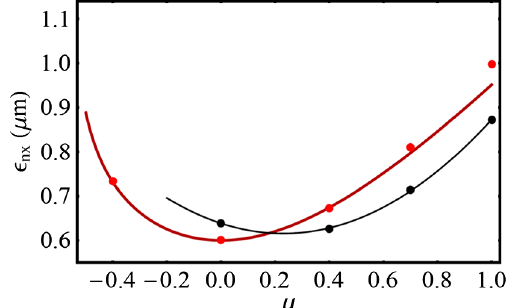
FIG. 4. Normalized projected rms emittance observed at the exit of the achromat as predicted by Eq. (32), red line, and determined by ELEGANT simulations (red dots) vs. μ , parametriz- ing the entry m 12 ¼ 15 ð 1 þ μ Þ L B = 2 of the transfer matrix M from the exit of the first to the entrance of the second bend, see Fig. 1. The black dots are from ELEGANT simulations carried out with the more accurate model of CSR including transient effects through entrance and exit of the dipoles. The black line is a quadratic fit, helping the eye to locate the